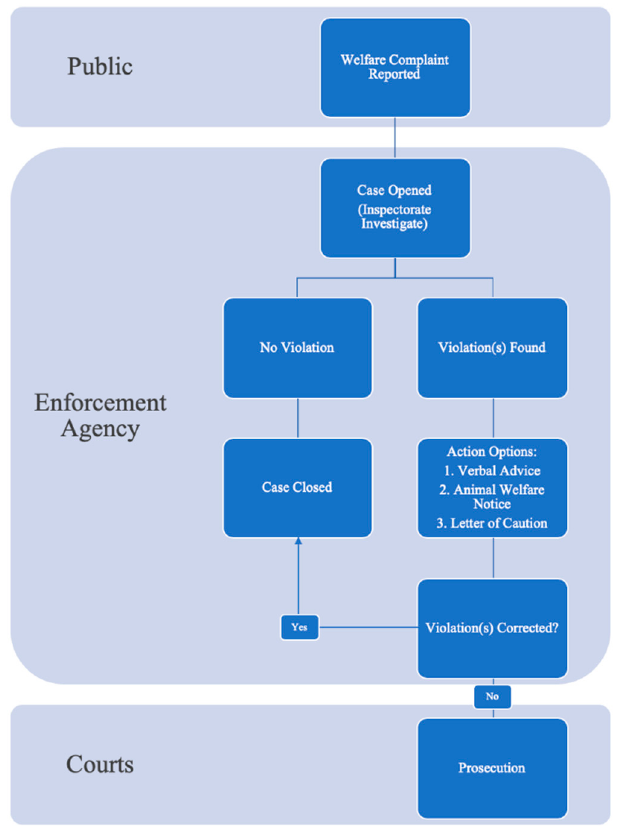
Figure 1. Flowchart of the Australian animal law enforcement process, indicating the parts where the public, enforcement agencies or the courts have the predominant